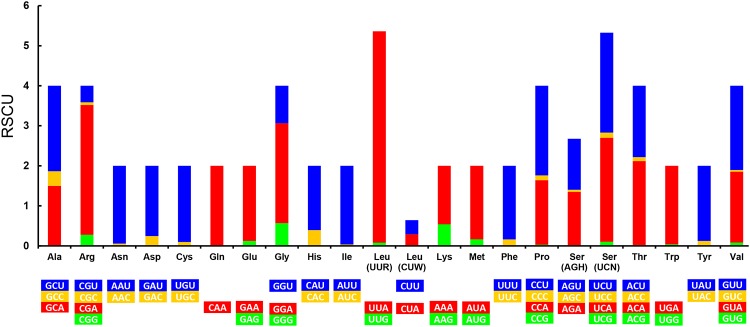
Relative synonymous codon usage (RSCU) in the An. sinensis mt genome.The RSCU values are represented on the y-axis, while the codon families for each amino acid are denoted on the x-axis.